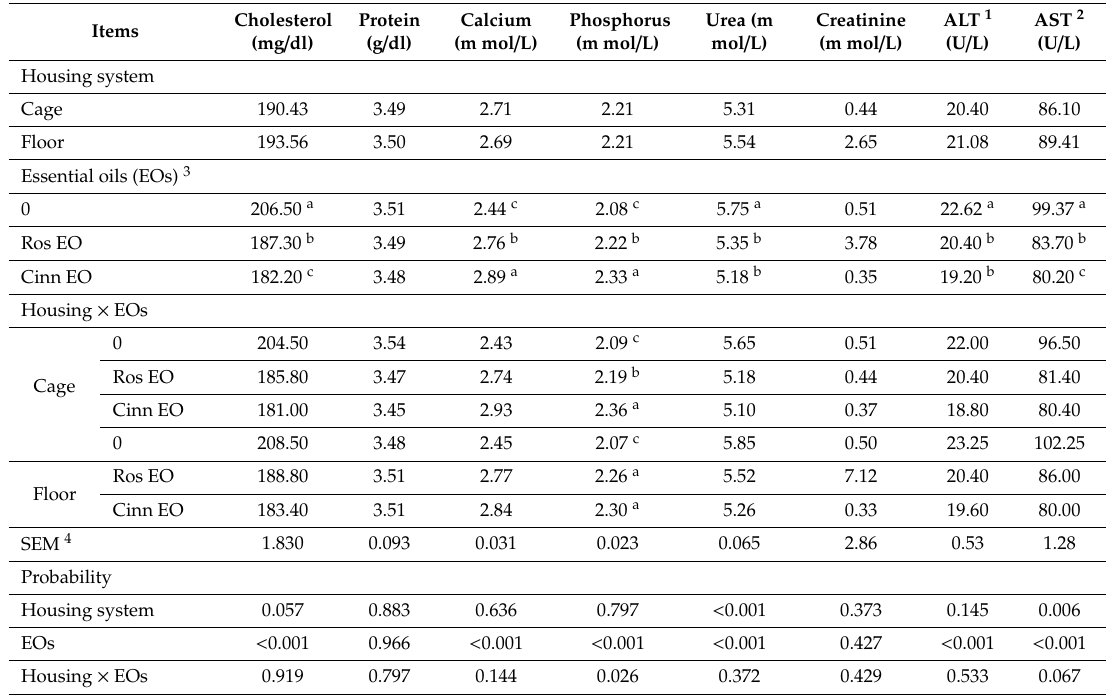
Table 10. Blood chemistry of laying hens as a ff ected by di ff erent housing systems, essential oils and their interaction during the